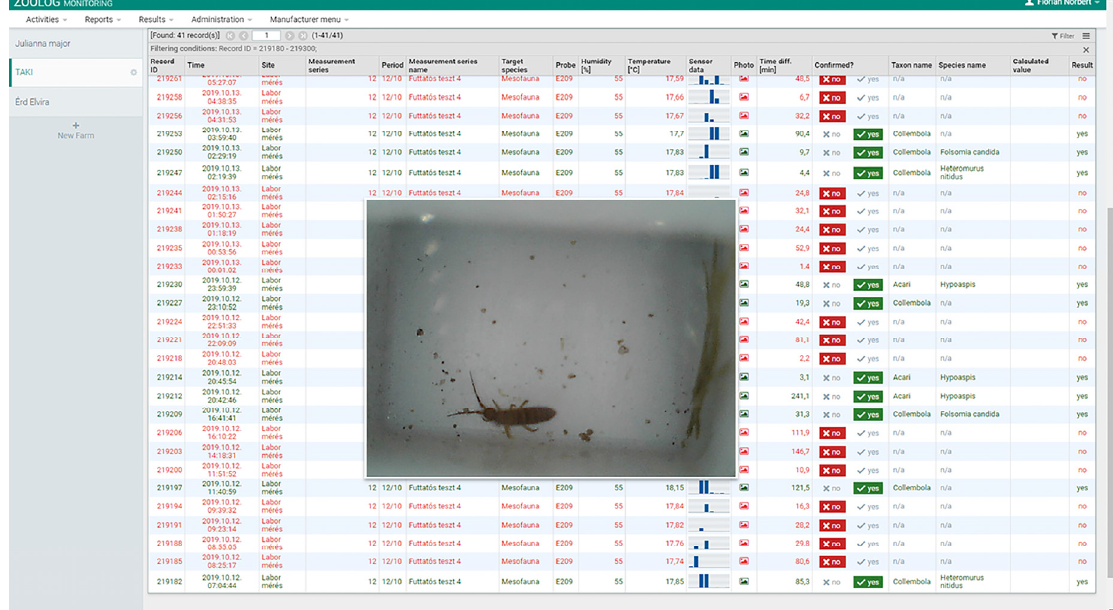
Figure 4. The user interface of the ZooLog Monitoring System. Each row corresponds to one detection. A photo is taken at each detection, which can be enlarged.